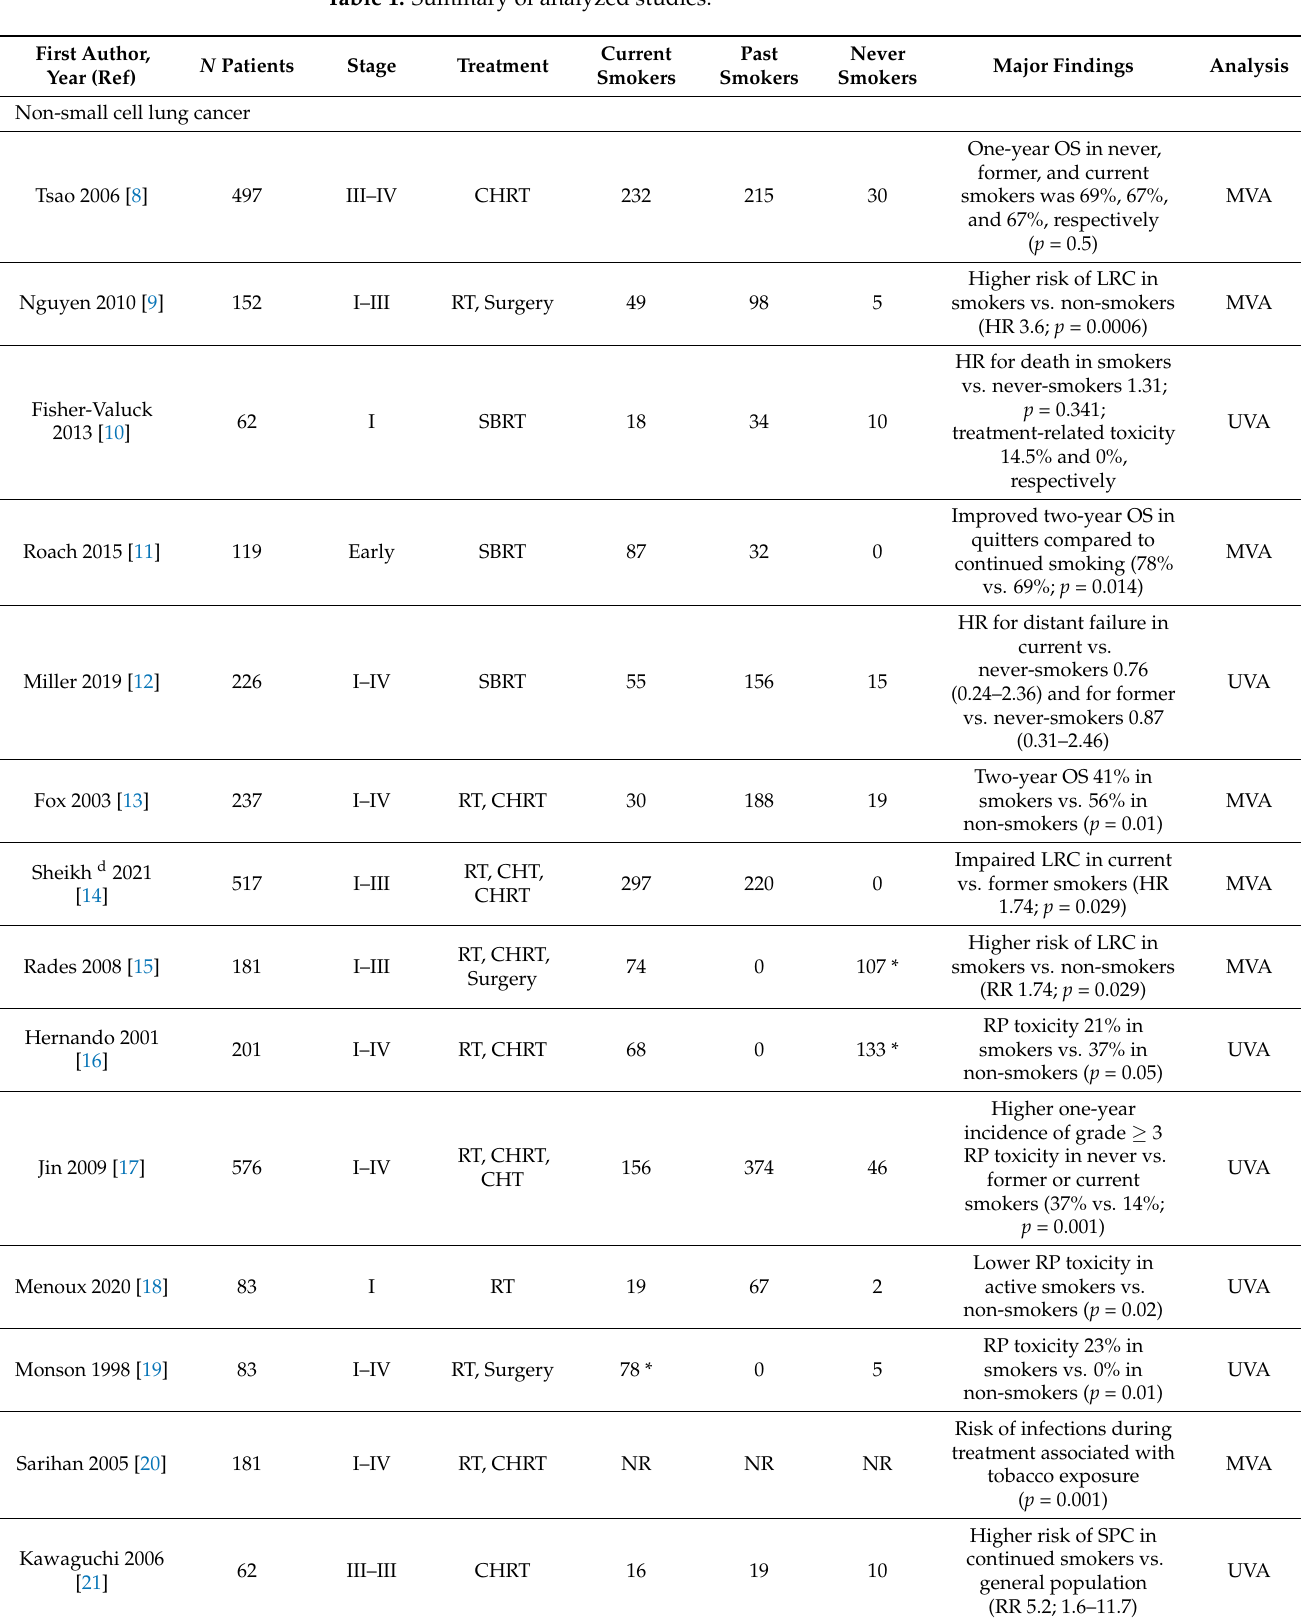
Table 1. Summary of analyzed